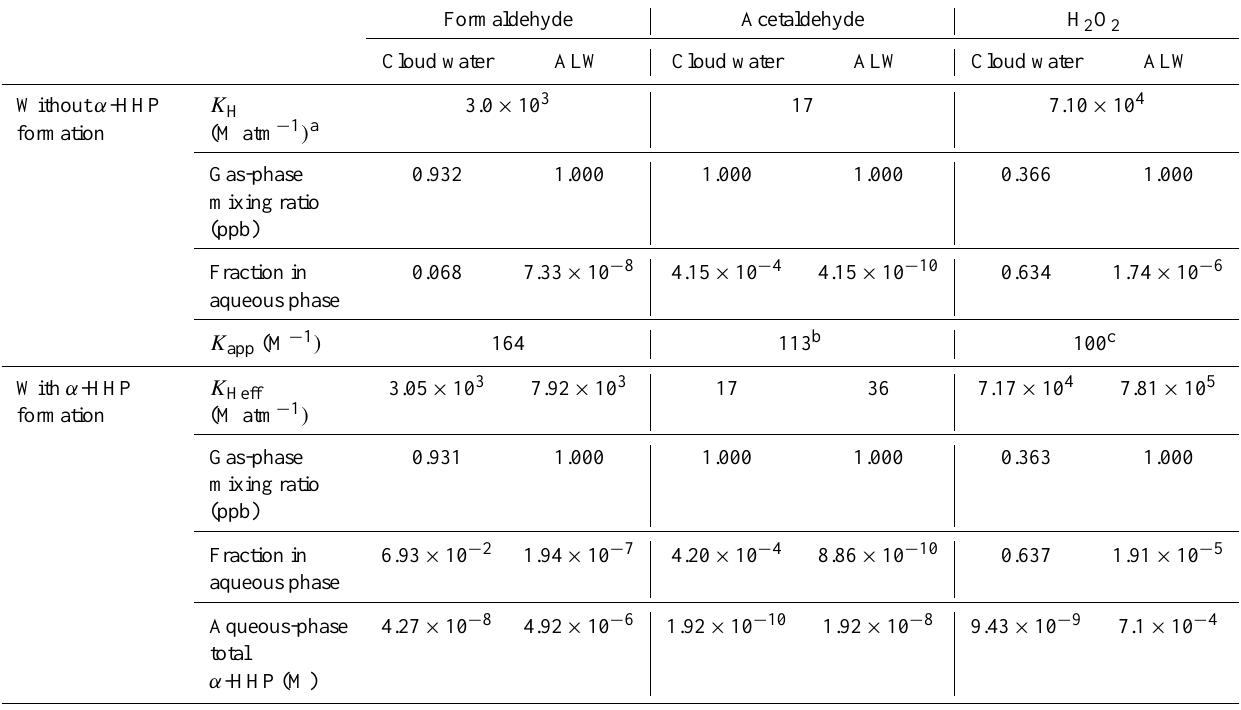
Table 6. Results of the atmospheric partitioning